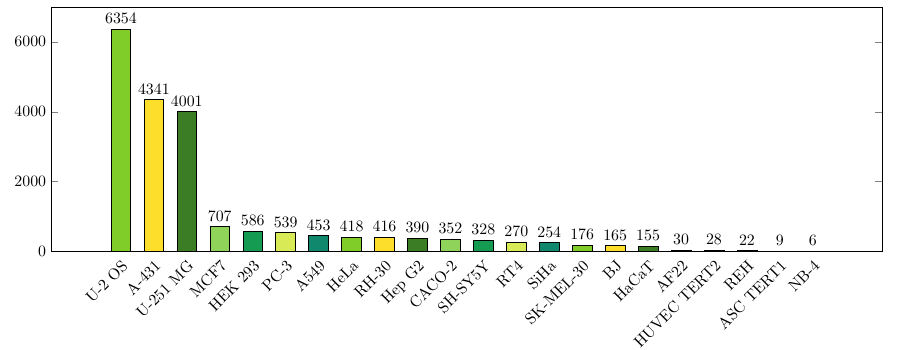
Figure 2. Cell line distribution shows that majority of the images in the dataset originate from three cell lines. Color coding is for visual separation of the